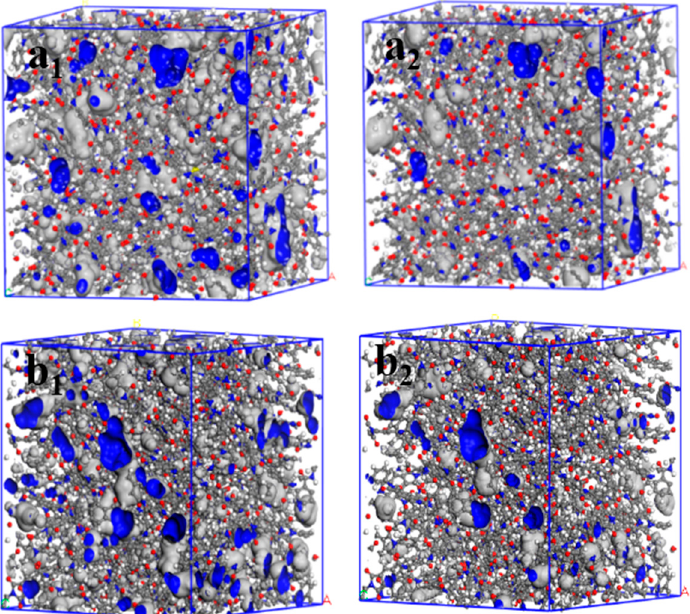
Figure 8. Three-dimensional representation of H 2 O and O 2 accessible volume in ( a1 , a2 ) DABPI, and ( b1 , b2 ) m-DABPI (grey: Van der Waals surface; blue: Connolly surface; a1 and b1: probe radius of 1.325 Å; a2 and b2: probe radius of 1.73 Å).